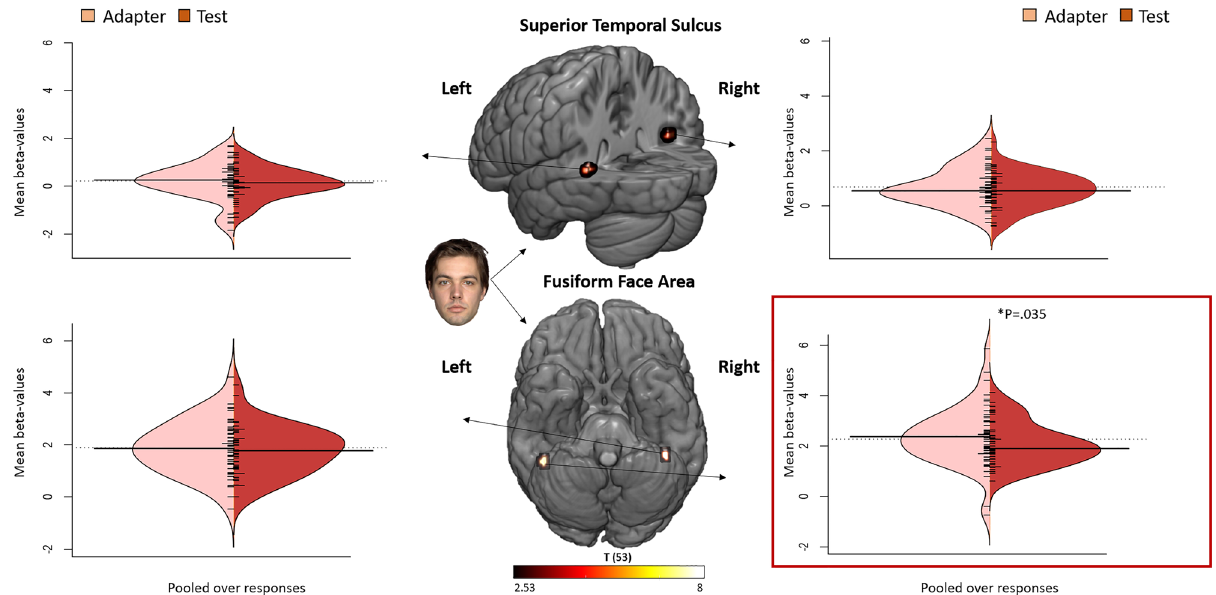
Fig. 6 Main effect of repetition in the right FFA. Split violin plots displaying effect size estimates (beta-values) as a function of ROI and repetition pooled over performance levels, during immediate (adapter) versus delayed (test) recognition task. This revealed a signi fi cant main effect of repetition in the right FFA ( p = 0.035, Bonferroni-corrected). The centre column displays the ROI locations and absolute t -values of the statistical maps (faces vs. houses) on which the ROI de fi nition is based ( q < 0.005, FDR-corrected). Horizontal lines represent the mean. N =